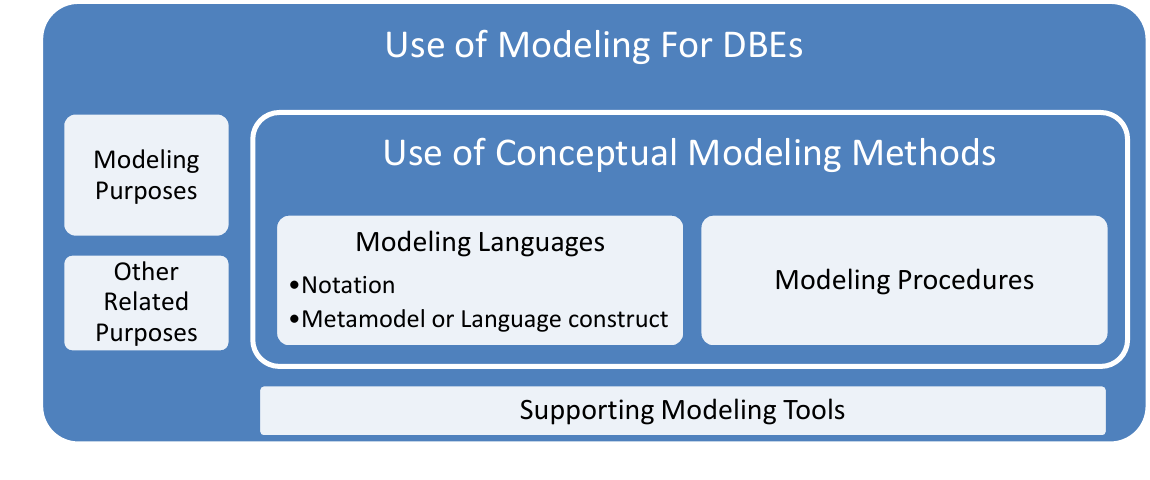
Figure 2. The structure of the results